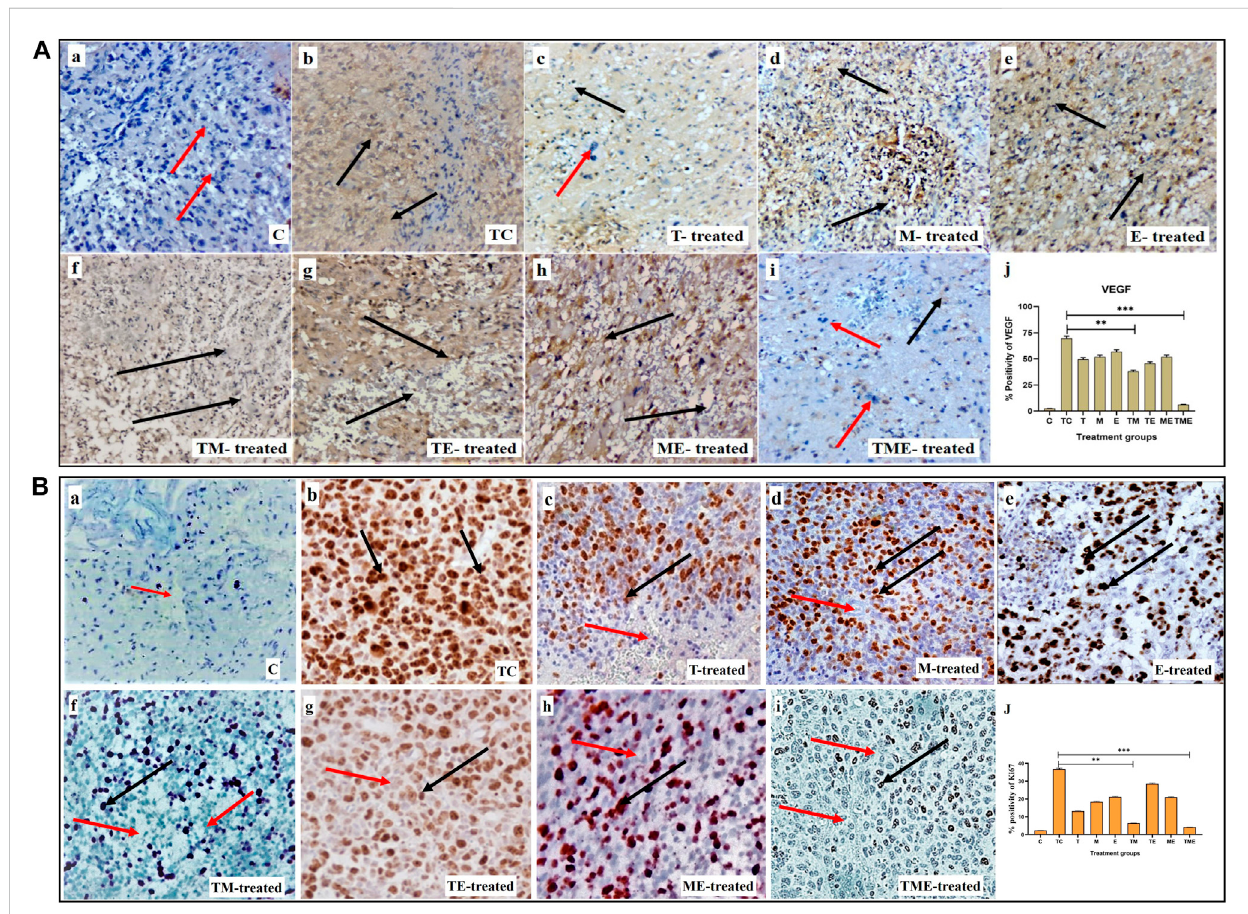
FIGURE 2 (A) IHC staining for VEGF in tumor sections from different experimental groups at 40x magni fi cation. (A-a – A-i) IHC staining for VEGF in various treatment groups, wherein cytoplasmic positivity is denoted by black arrows and cytoplasmic negativity is denoted by red arrows respectively. (A-j) Quanti fi cation of cytoplasmic positivity for VEGF in each group. (B) Ki67 nuclear expression in different experimental groups at 40x magni fi cation. (B-a – B-i) IHC staining for Ki67 in various treatment groups, wherein nuclear positivity is denoted by black arrows and nuclear negativity is denoted by red arrows respectively (B-j) Quanti fi cation of nuclear positivity for Ki67 in each group (**P < 0.001, *** P < 0.0001). 3.4. Triple-drug combination signi fi cantly enhanced the ROS levels and levels of antioxidant and non-antioxidant enzymes